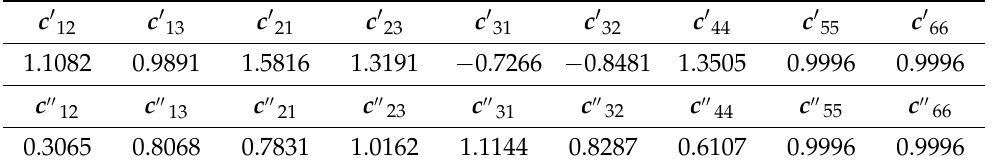
Table A2. The calibrated material parameters of the Barlat Yld2004-18p yield function (Equations (A1)–(A3)) [65] with an exponent of 6 for the 25 ◦ C die-quenched condition of Ductibor ® 1000-AS.